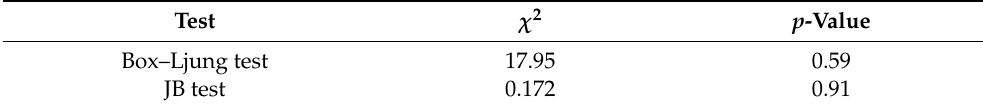
Table 12. The resutls of the Box–Ljung and Q-statistics tests.